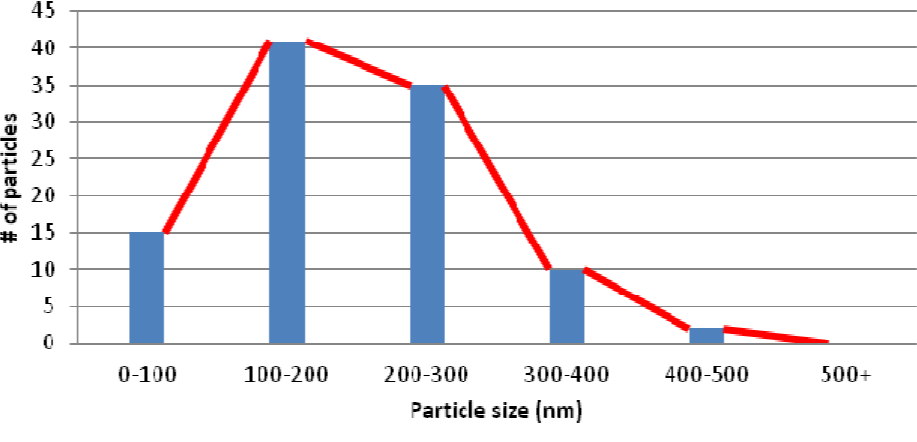
Figure 6. Size distribution of gold nanoparticles on the silicon